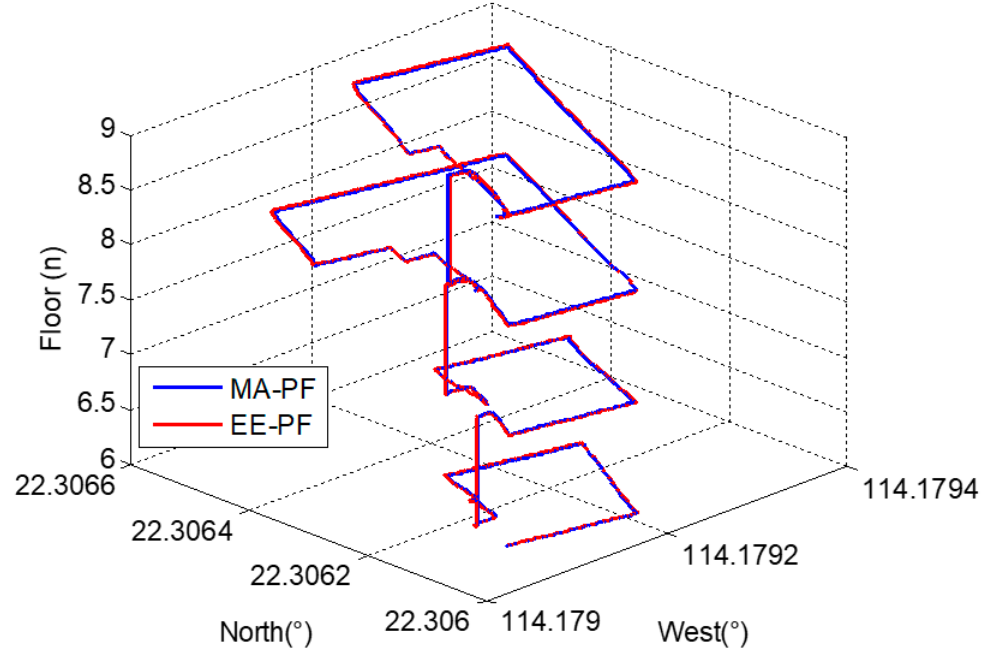
Figure 15. Trajectories Comparison of MA-PF and